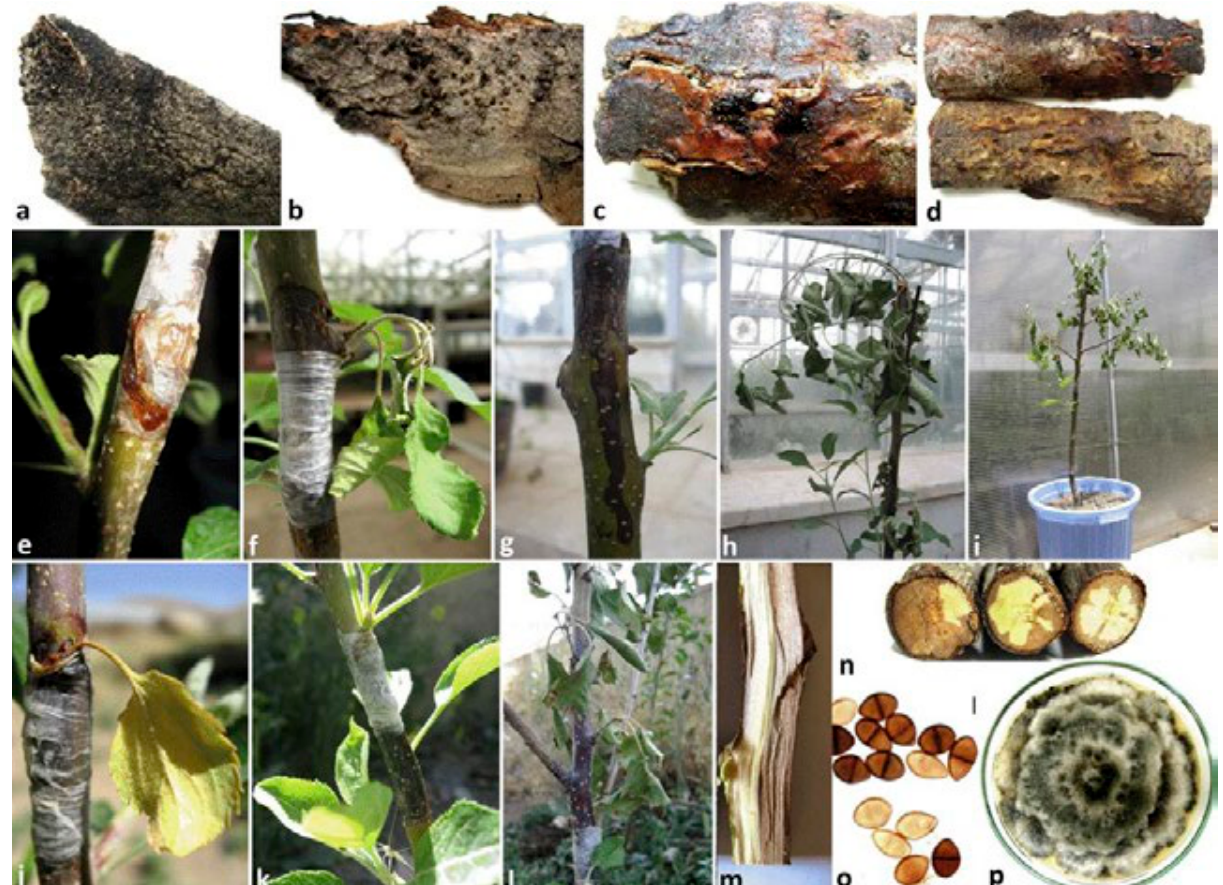
Figure 1. Disease symptoms observed in orchards (a-d), greenhouse (e-i) and field trials (j-l). Vascular discoloration of infected shoots (m-n). Septate and aseptate conidia of Diplodia bulgarica (o), and a 2-wk old colony of the fungus on PDA (p). Bar =